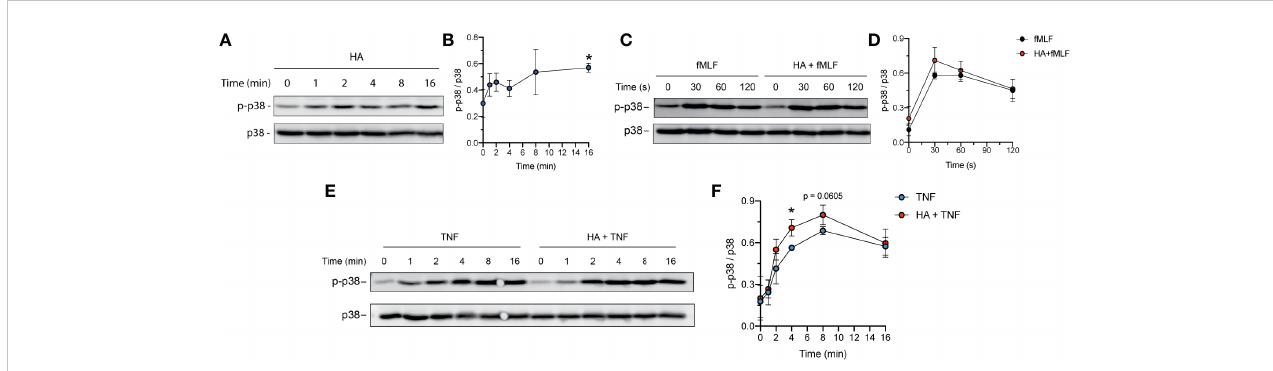
FIGURE 6 Total and phospho p38 MAPK in TNF a - and HA-stimulated neutrophils. (A) Western blot showing the phosphorylated and total p38 MAPK protein over time in neutrophils primed with HA (200 m g/mL). Data is representative of 3 independent experiments. (B) Graph shows quanti fi cation (mean ± SD) of phospho-p38 normalized to total p38 protein (y-axis) over time (x-axis), n = 3. (C) Western blot showing the phosphorylated and total p38 MAPK protein in neutrophils upon fMLF activation (100 nM, 0 – 2 min) at t = 16 min of priming in the presence (HA + fMLF) or absence (fMLF) of HA (200 m g/mL). Data is representative of 3 independent experiments. (D) Graph shows quanti fi cation (mean ± SD) of phospho-p38 normalized to total p38 protein (y-axis) over time (x-axis) during activation with fMLF at t = 16 min of priming with (HA + fMLF) and without (fMLF) HA, n = 3. (E) Abundance of phosphorylated and total p38 MAPK protein over time in neutrophils primed with TNF a (10 ng/mL) and HA + TNF a (200 m g/mL HA). Data is representative of 3 independent experiments. (F) Graph shows quanti fi cation (mean ± SD) of phospho-p38 normalized to total p38 (y-axis) over time (x-axis) in TNF a - primed and HA+TNF a co-primed neutrophils, n = 3. Statistical analysis for individual time points was performed using unpaired two-tailed t-test, (B, F) ; *p < 0.05.